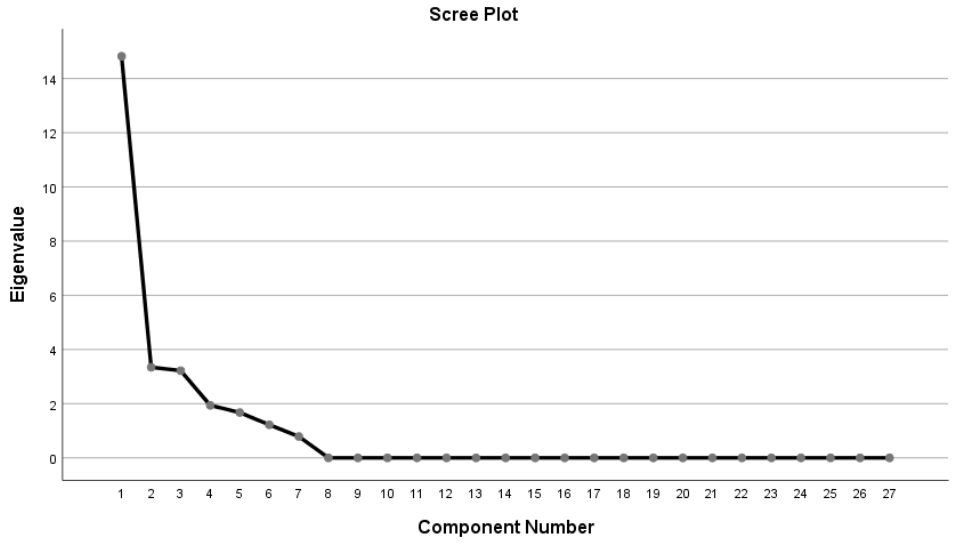
Figure 18. Setup of factorial analysis in SPSS to extract principal components.